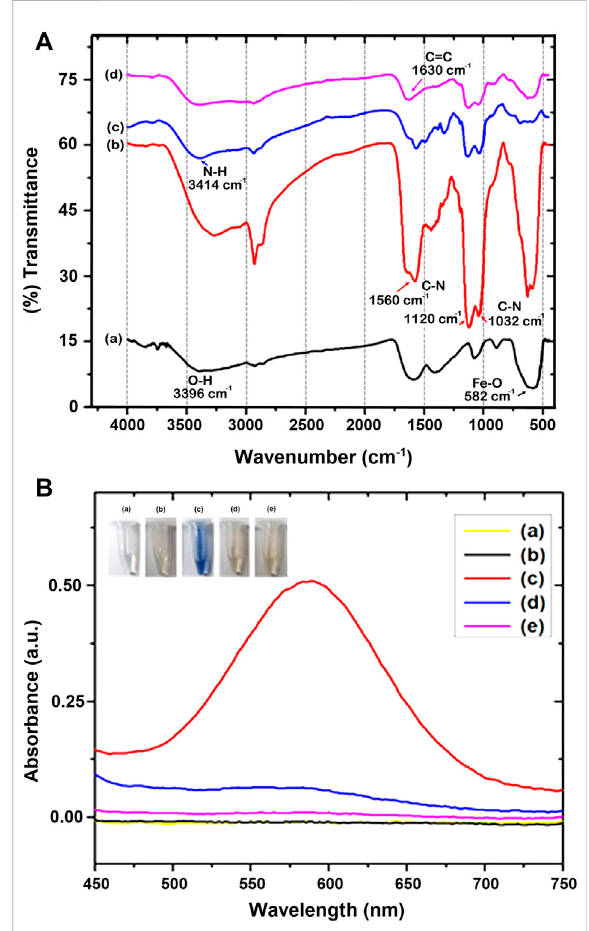
FIGURE 4 (A) FT-IR spectra of (a) Fe 3 O 4 , (b) Fe 3 O 4 @APTMS, (c) Fe 3 O 4 @ APTMS-GA, and (d) Fe 3 O 4 @APTMS-GA-acrylate. (B)